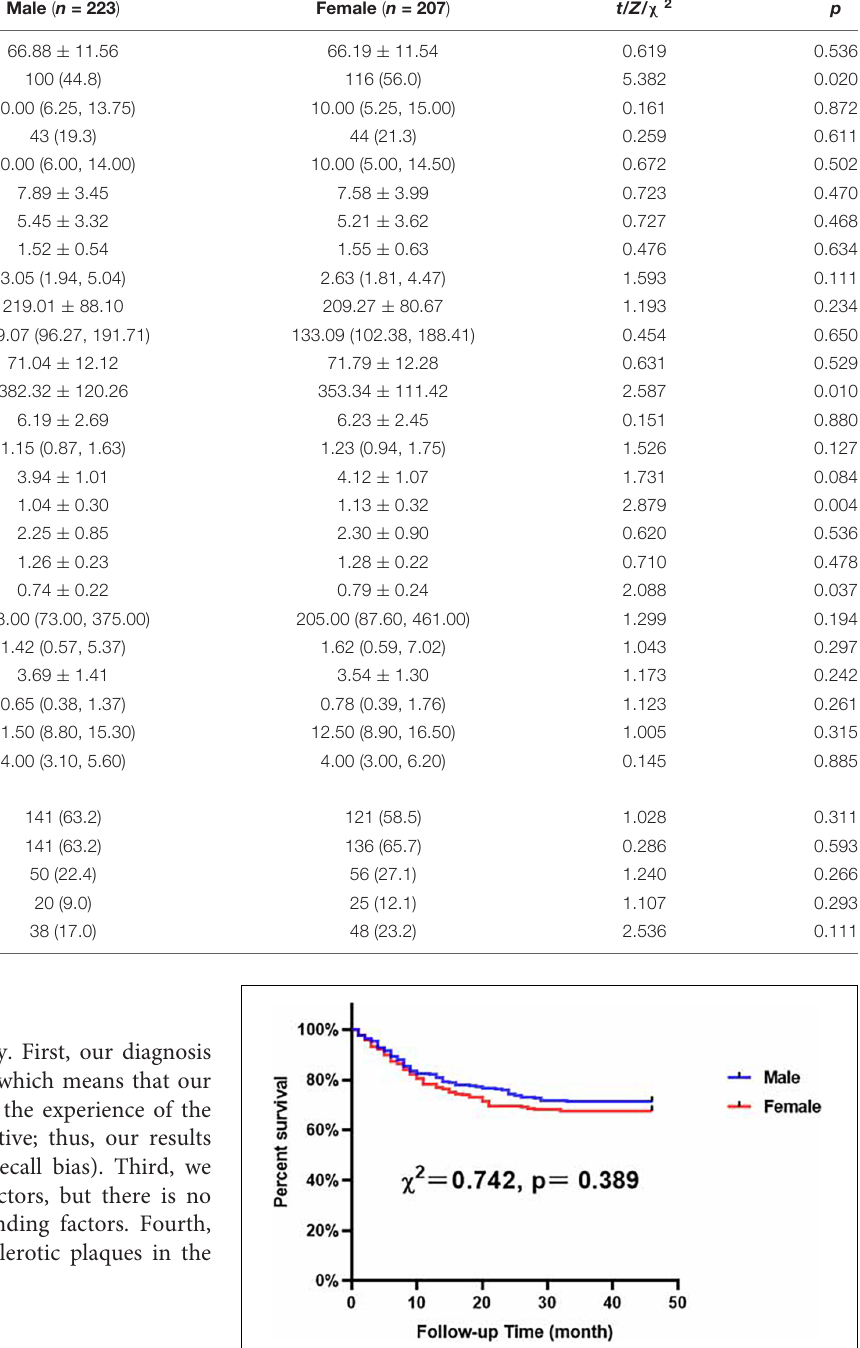
Moreover, appropriate prevention programs should be tailored to different sex LEASO groups as well as different risk